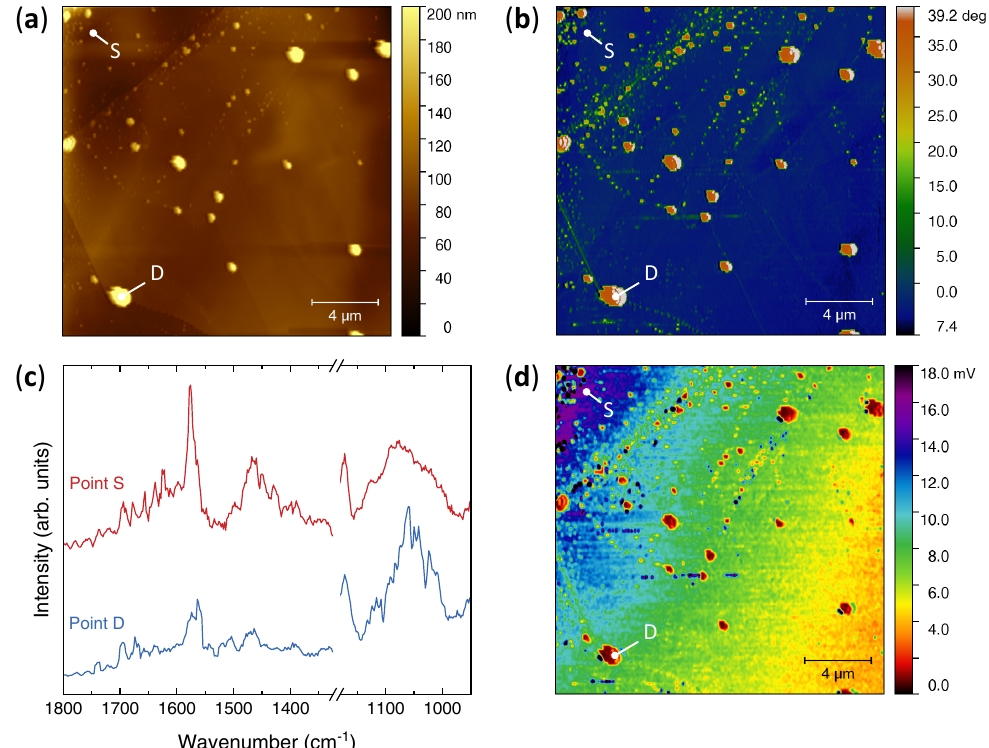
Figure 3. Infrared nanospectroscopy of intercalated MoS 2 . ( a ) AFM topography map. ( b ) Phase image of the same area. ( c ) nano-IR absorption spectra acquired in correspondence of a droplet (solid blue line, point D) and of the MoS 2 exposed surface (solid red line, point S). ( d ) IR absorption map of the same area acquired in correspondence of the EMIM-breathing mode at ∼ 1572 cm − 1